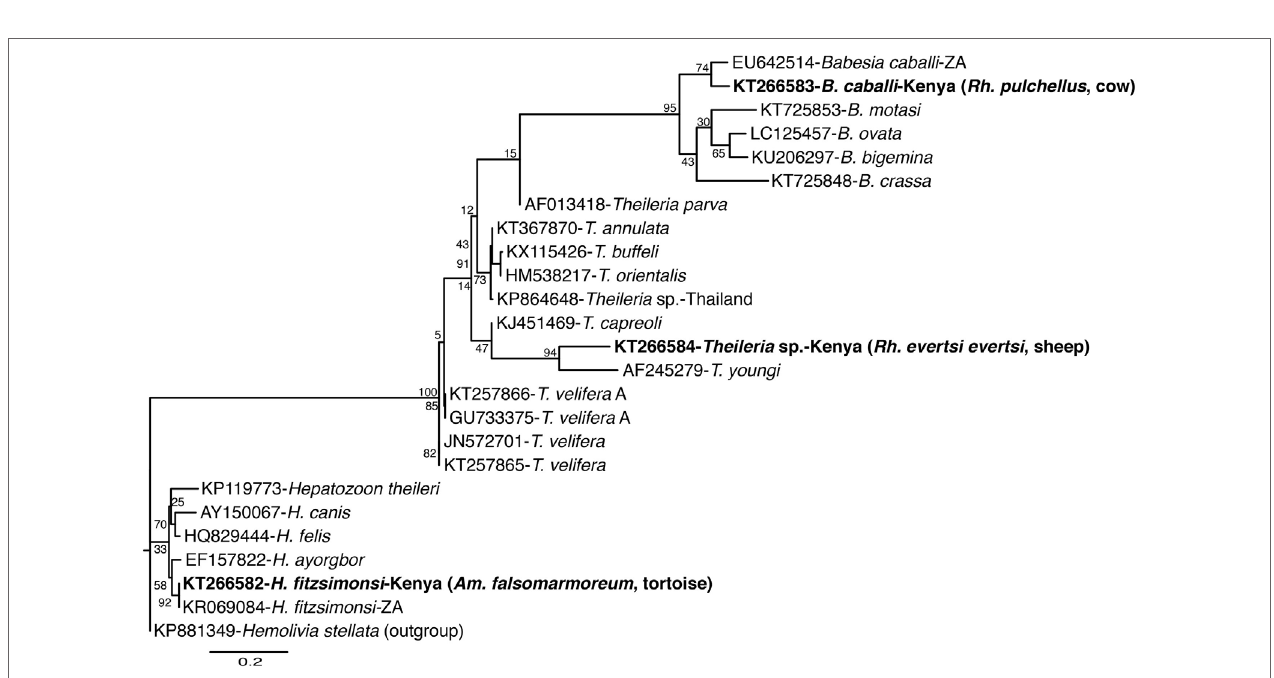
FigUre 5 | Maximum likelihood phylogenetic analysis of 18s rrna gene fragments of apicomplexa ( Hepatozoon , Babesia, and Theileria ) sequences identified with related sequences . GenBank accession numbers, species identifications, isolates, and country of origin are indicated for each 16S rRNA gene sequence. Sequences from this study are in bold with tick and vertebrate host species associated with the study isolates indicated in brackets. Bootstrap values at the major nodes are of percentage agreement among 1,000 replicates. The branch length scale represents substitutions per